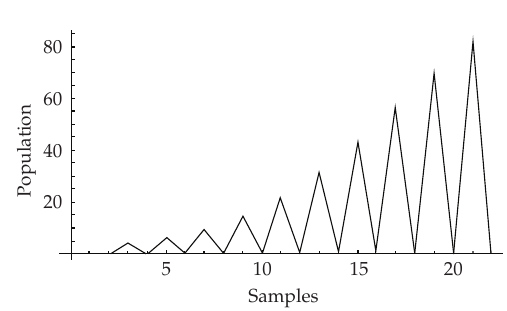
Figure 3: μ (cid:8) 2 , K (cid:8) 200 , d (cid:8) 0 , p (cid:8) 0 . 01 , α (cid:8) 0 . 001 , and γ (cid:8) 0 .